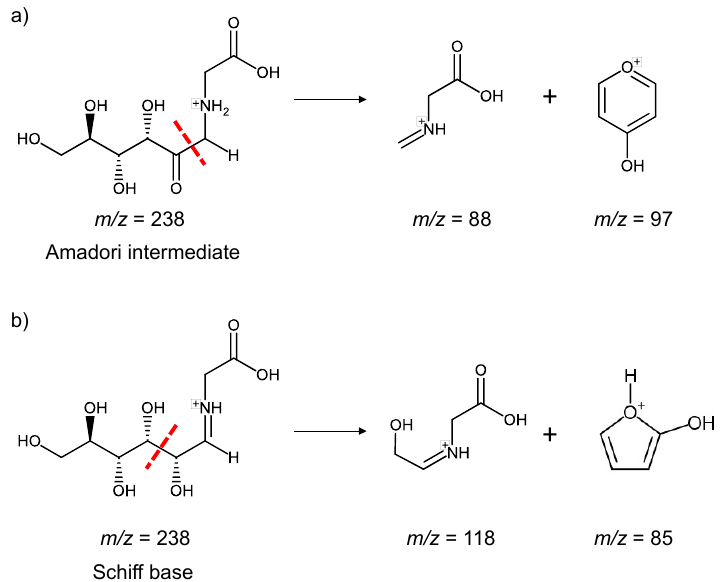
Scheme 2. The main diagnostic fragmentations of: ( a ) Amadori intermediate and ( b ) Schiff base.